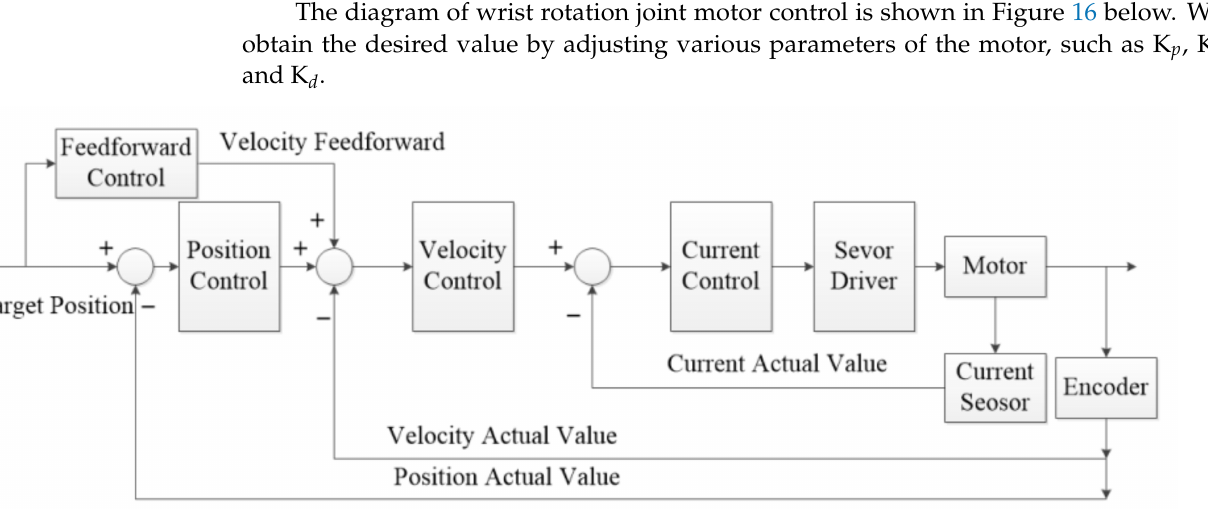
Figure 16. The diagram of wrist rotation joint motor